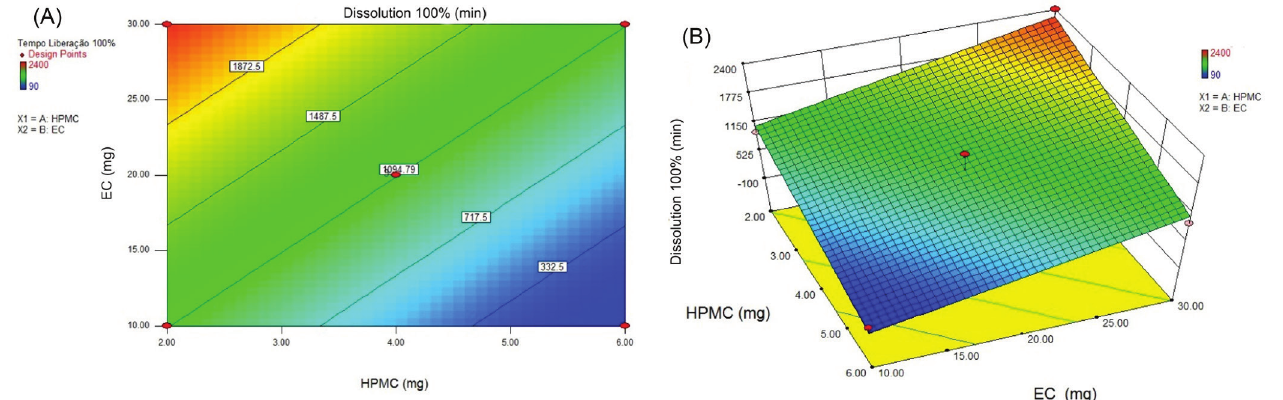
FIGURE 6 - Outline map A) and response surface B) for the experimental results of factorial experimental design 2 2 . Response release time 100% (min) according to the amount of HPMC (mg) and EC (mg).